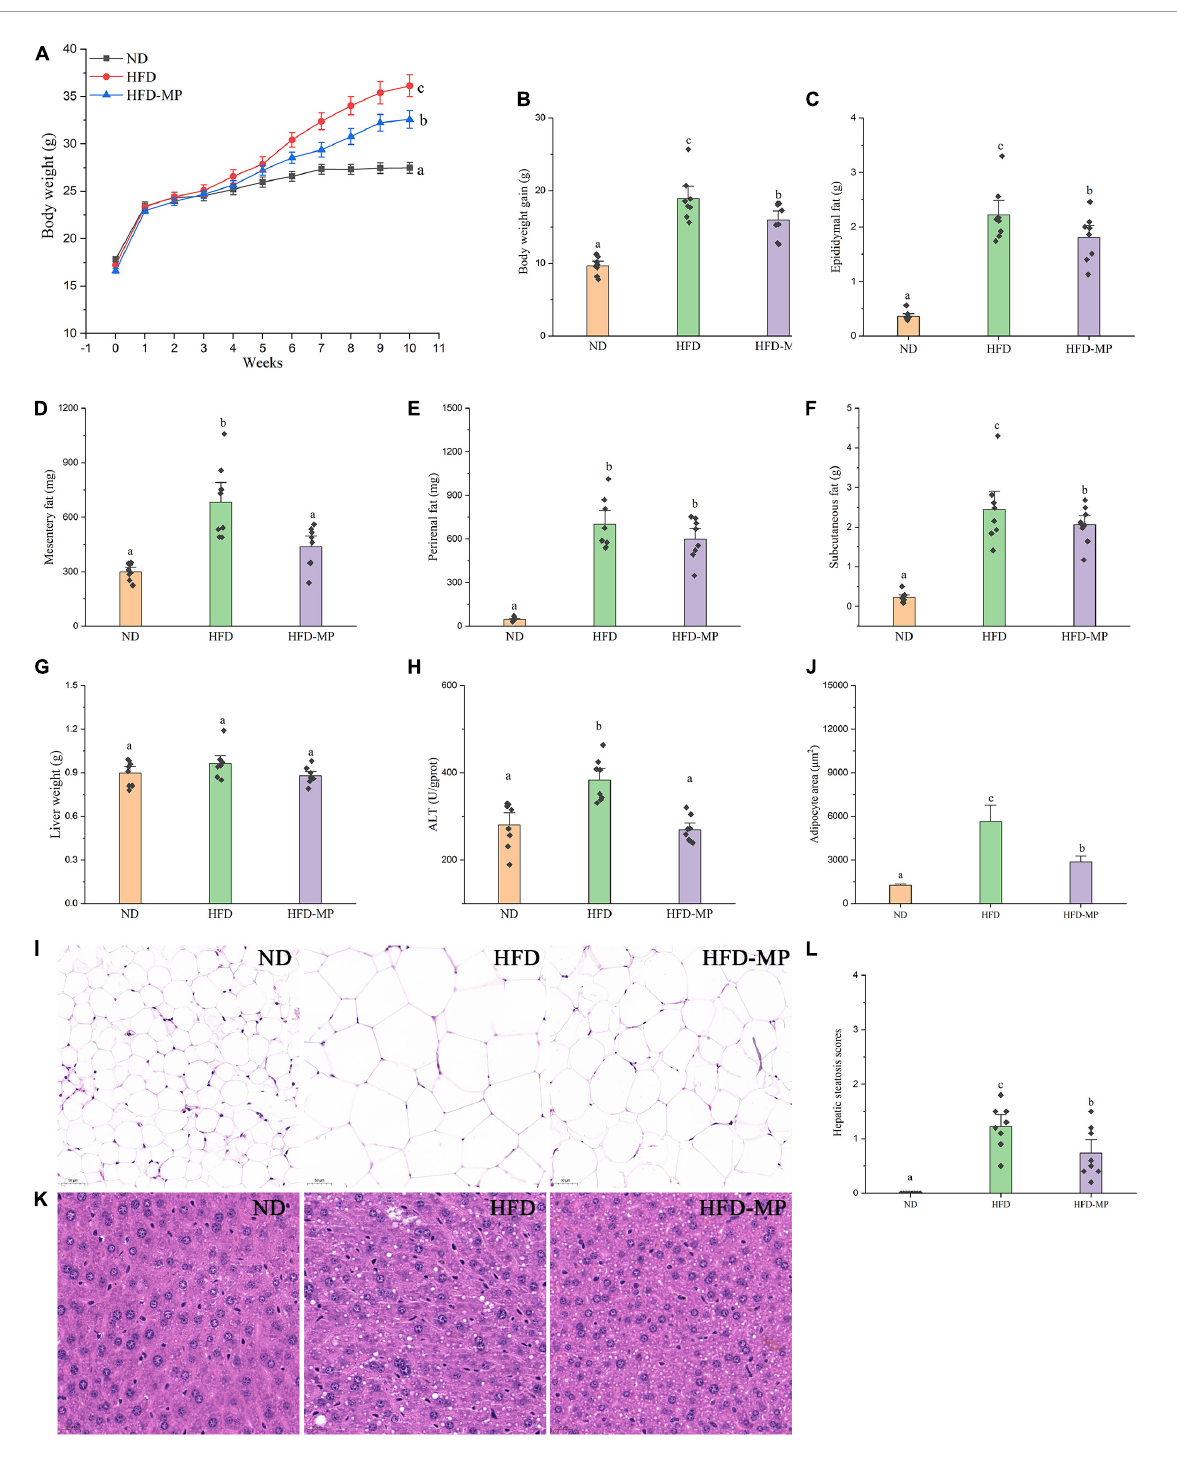
FIGURE1 Impact of HFD and MP intervention on body features of mice. (A) Body weight, (B) body weight gain, weights of (C) epididymal, (D) mesentery, (E) perirenal, (F) subcutaneous fat pads, (G) liver weight, (H) plasma alanine transaminase (ALT) level, epididymal adipocyte sections after H&E staining (I) , quantification of adipocyte area by ImageJ software (J) , liver (K) sections after H&E staining, and hepatic steatosis scores (L) . The data are represented as the mean ± SEM. Statistical differences were carried out by one-way ANOVA followed by Turkey’s test, p < 0.05 indicates significant